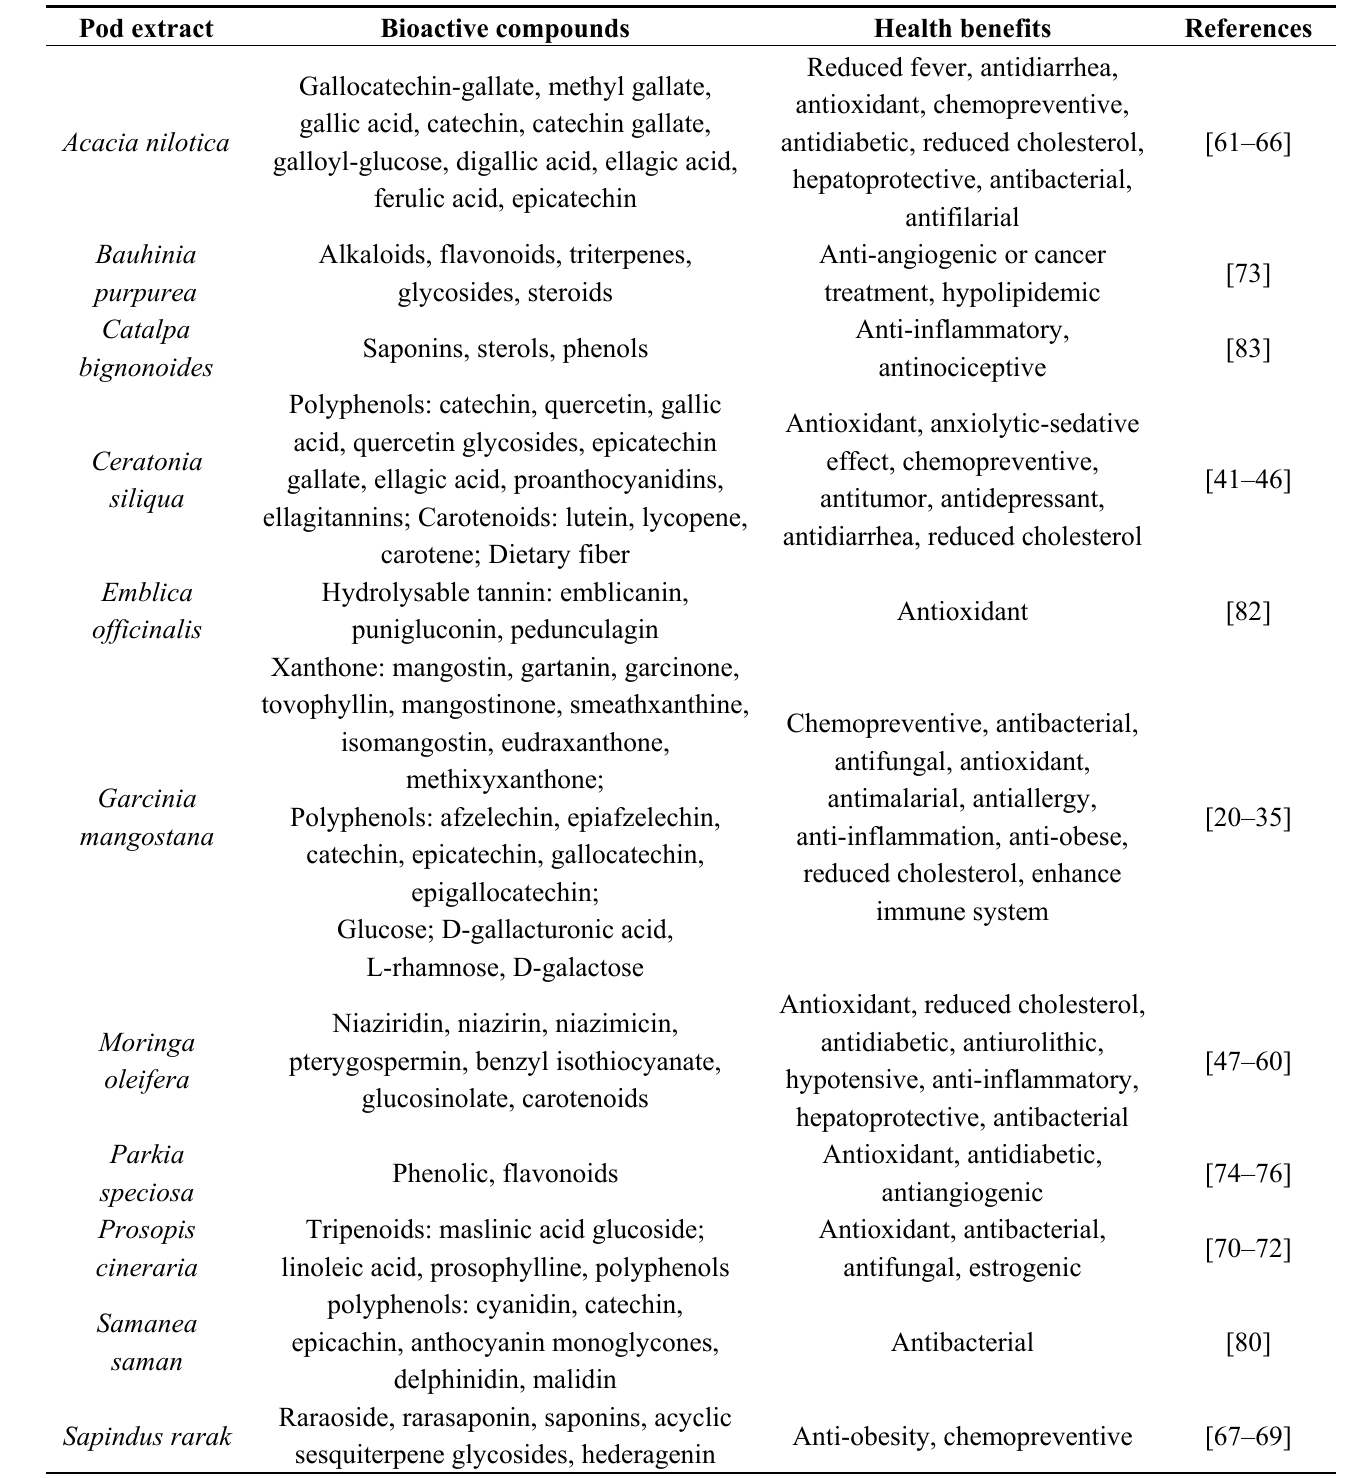
Table 1. Bioactive compounds and health benefits of fruit